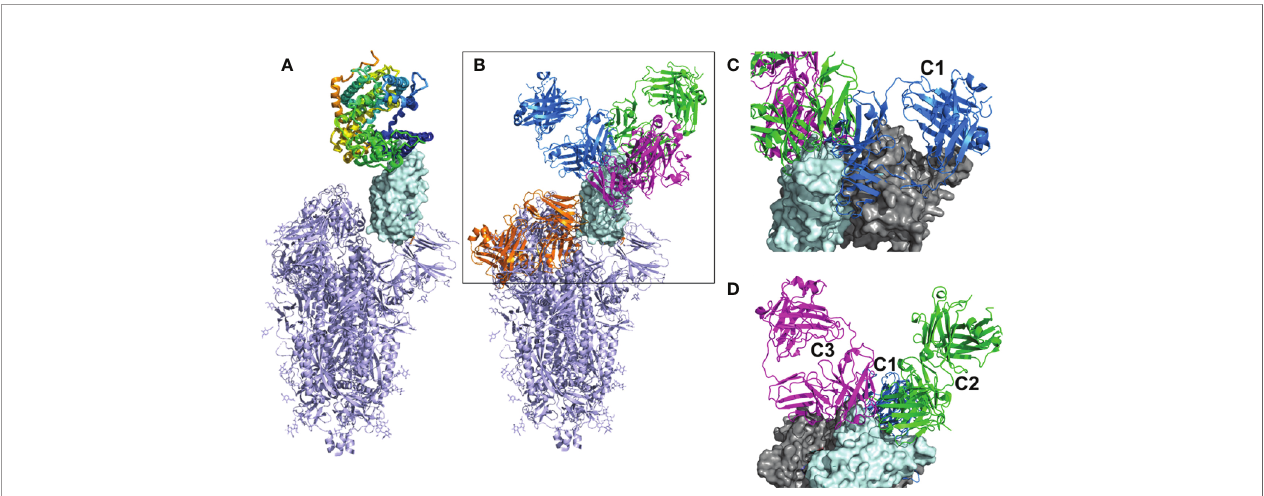
FIGURE 1 | Overall view of ACE2 and NAbs binding to SARS-CoV-2 S protein. (A) Ribbon diagram of the SARS-CoV-2 S protein, with one RBD in the up conformation (cyan surface) interacting with ACE2. (B) General location of NAb binding epitopes, where an example C1 NAb is colored blue, C2 green, C3 magenta and C4 orange. The fi gure highlights that extensive conformational changes are required before C4 NAbs can bind to S. (C) View of two RBDs from an S trimer (cyan and grey surfaces) in the down conformation, to show that C1 NAbs cannot bind to their epitope while the RBD is in the down conformation, due to steric hinderance. (D) Alternative view of adjacent down RBDs in the S trimer showing C2 and C3 NAb epitopes are accessible while RBD is in the down conformation and that some NAbs can bind across an RBD-RBD trimer interface and interfere with RBD opening to bind